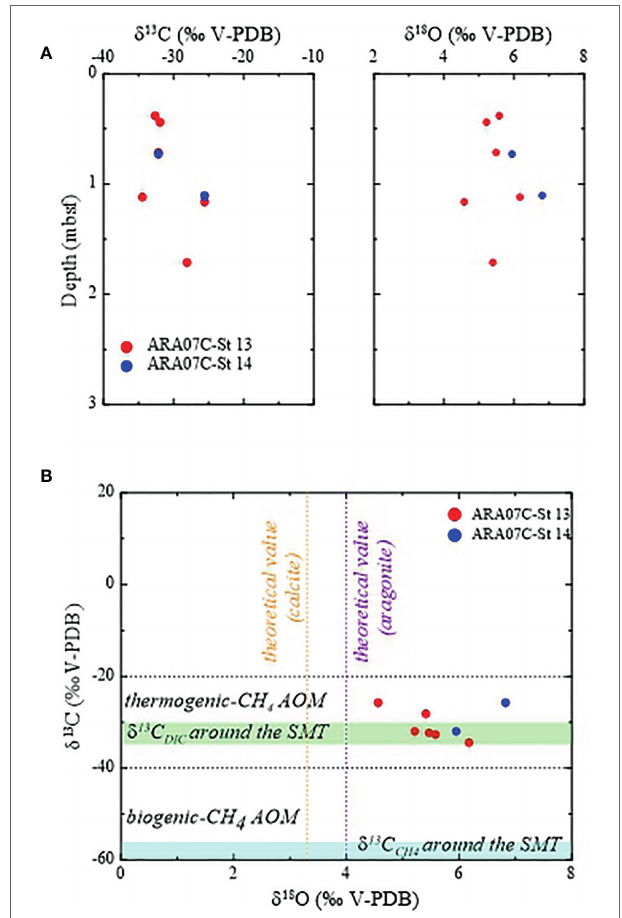
FIGURE 5 | (A) Downcore profiles of δ 13 C and δ 18 O in MDACs from the ARAON Mounds. (B) Scatter plots of δ 13 C versus δ 18 O in MDACs from the ARAON Mounds. The violet and light orange line are the theoretical δ 18 O δ 18 O argonite and calcite estimated by the equation of Kim et al. (2007) and Kim and O’Neil (1997) , respectively. The upper and lower black lines are boundaries for MDACs incorporated with thermogenic CH 4 and microbial CH 4 , respectively (Naehr et al., 2007; Crémière et al., 2016; Crémière et al., 2018). The cyan area and light green area are the ranges of δ 13 C CH4 (Kim et al., 2020) and δ 13 C DIC (this study) around the SMT, respectively. Red closed circles: MDACs from Site ARA07C-St 13 and blue closed circles: MDACs from Site ARA07C-St